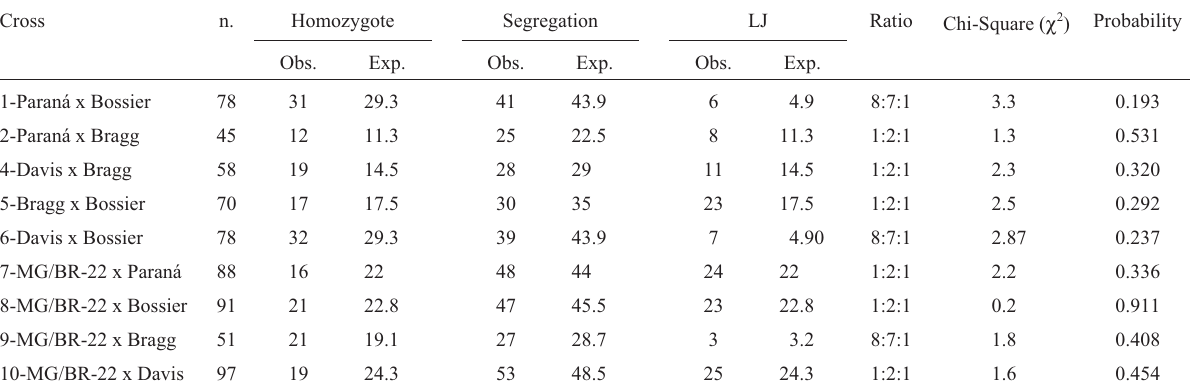
Table IV - Observed and expected phenotypic ratios of number of days to flowering in the F 3 populations. Cross n. Homozygote Segregation LJ Ratio Chi-Square ( χ 2 ) Probability Obs. Exp. Obs. Exp. Obs.